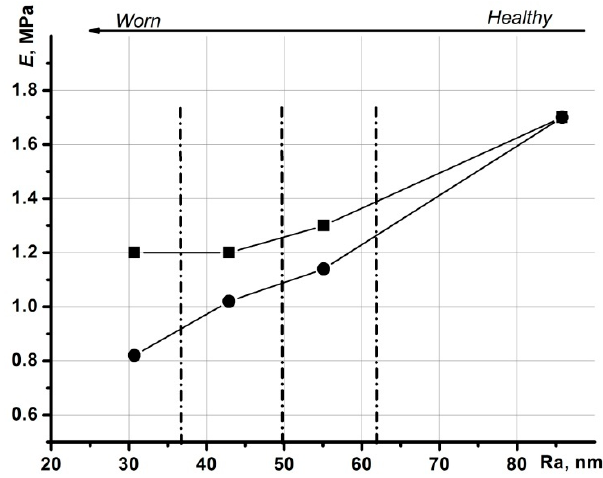
Figure 6. Relationships concerning Young’s modulus of cartilage wear: round dots represent the values of Young’s modulus on the surface; square dots represent the maximum values of Young’s